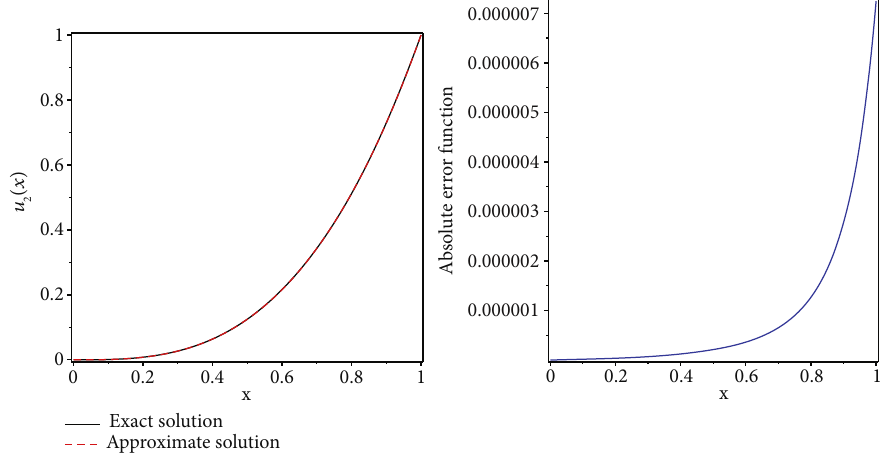
Figure 8: The graphs of the exact and approximate solutions and the absolute error function of ~ u